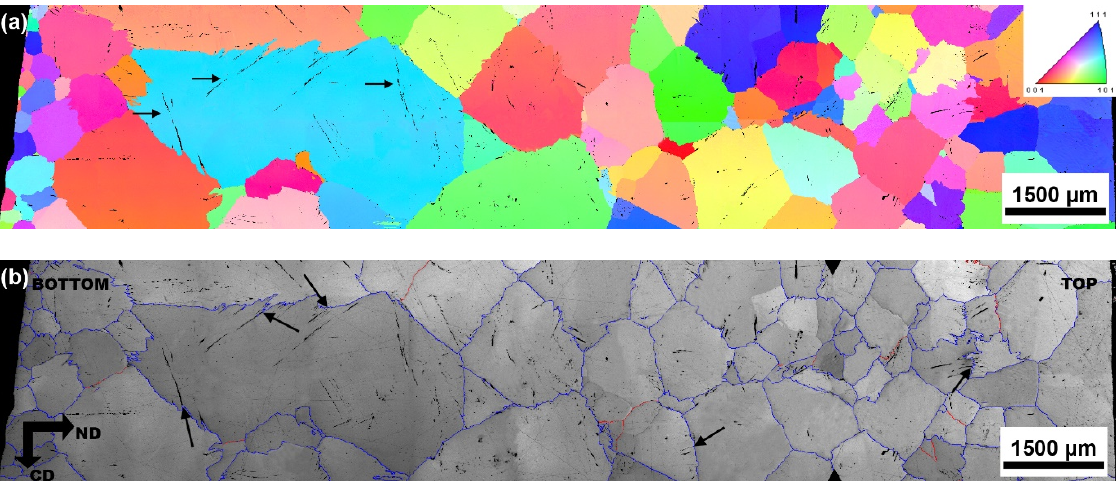
Figure 1. Distribution of austenite decomposition products in δ-ferrite across the thickness of a thin strip; ( a ) IPF orientation map for normal direction (ND)—the arrows indicate non-parallel products of WA decomposition within a single δ-ferrite grain; ( b ) IQ map showing high-angle grain boundaries (HAGB—blue, α > 15°) and low-angle grain boundaries (LAGB—red, 2°< α < 15°) of δ-ferrite grains. The arrows show nucleation of WA at δ-ferrite grain boundaries and triangles mark the area of final solidification.